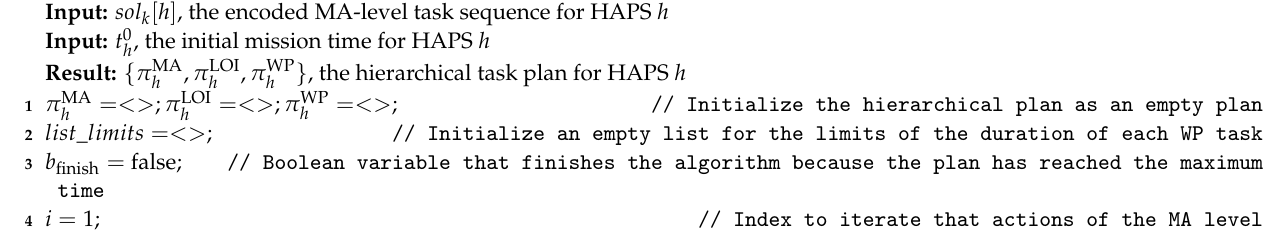
Algorithm 1: Temporal hierarchical task